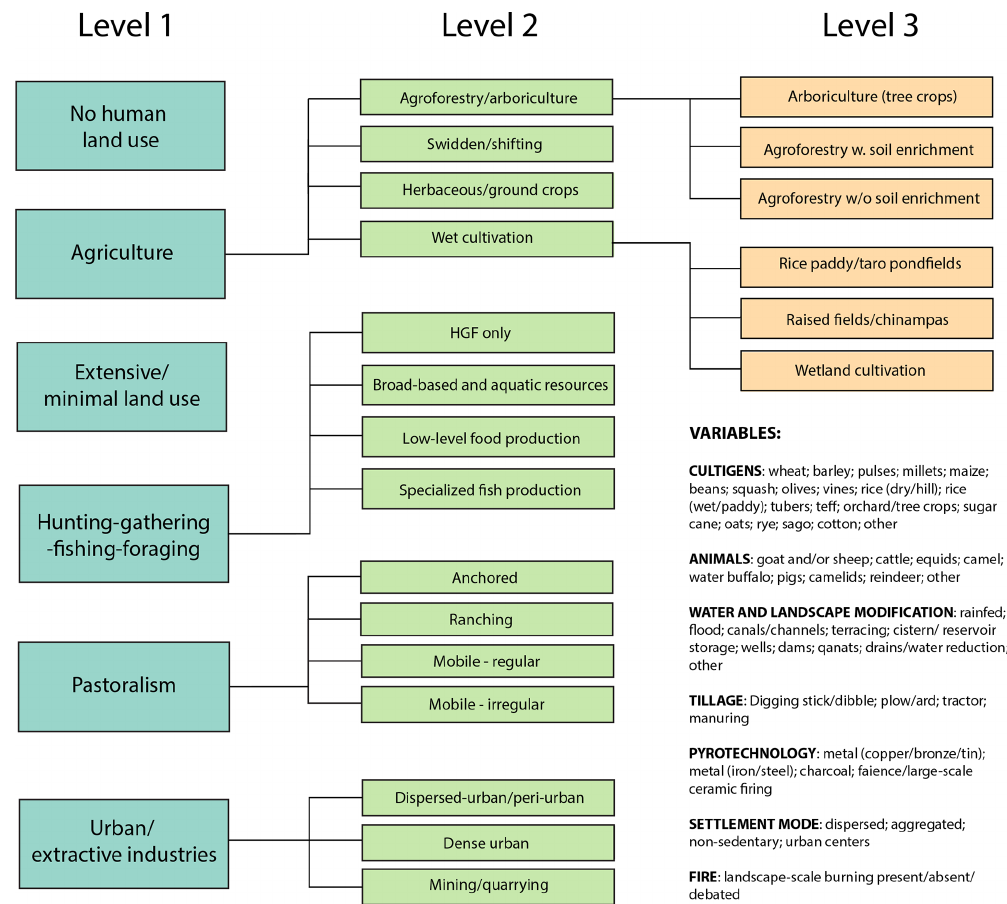
Figure 4. The hierarchical scheme of land use classes used for global mapping in LandCover6k (updated from Morrison et al., 2018).